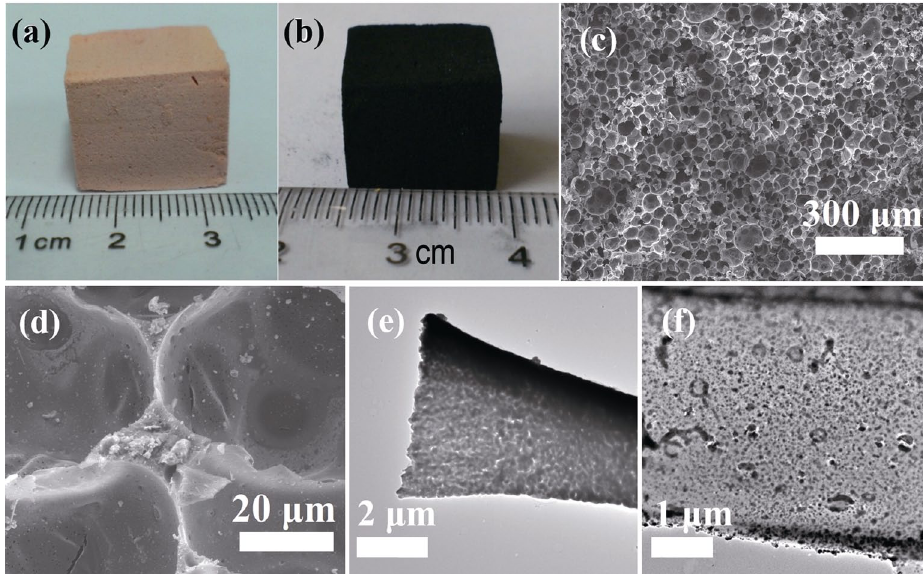
Fig. 7 (a) Photograph of the foamed green body and (b) ZrC/C foam obtained from pyrolysis at 1600 ℃ for 1 h. SEM images of ZrC/C foam after pyrolysis at 1600 ℃ with (c) low and (d) high magnification. TEM images of (e) the strut and (f) cell wall of ZrC/C foam after pyrolysis at 1600 ℃ [23]. Reproduced with permission from Ref. [23], © Elsevier Ltd.